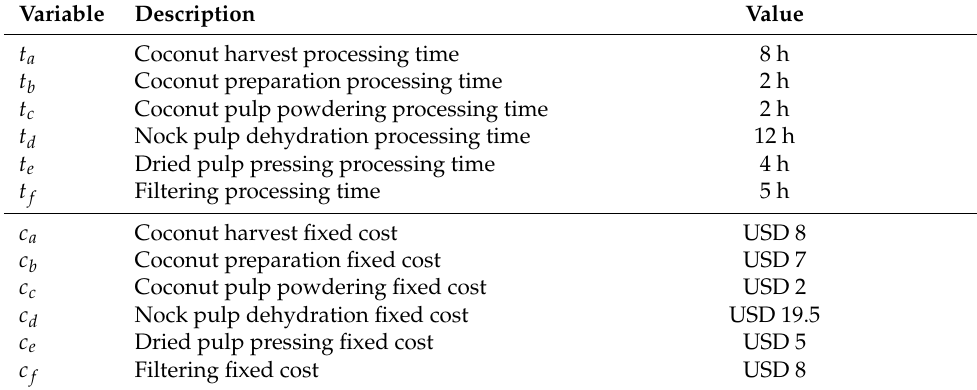
Table 2. Life cycle inventory (LCI) data: decision-making approach variables for standard extraction method ( i =